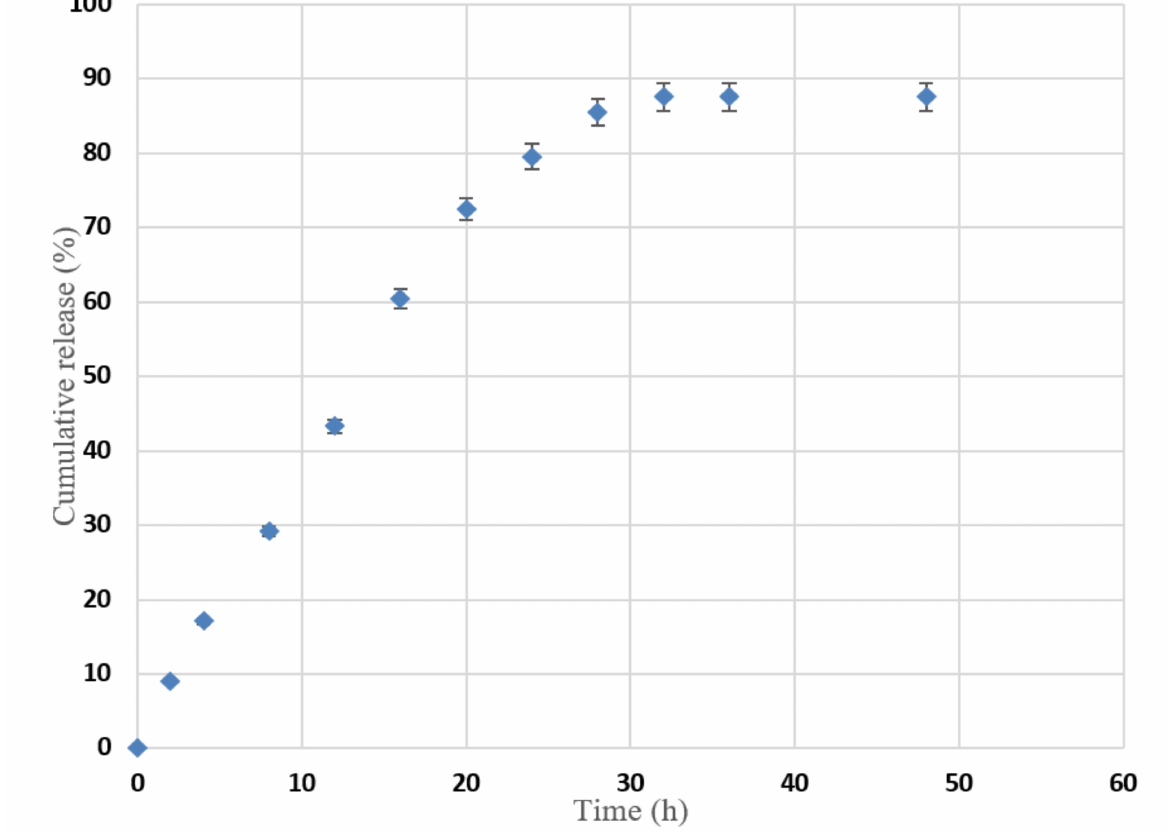
Figure 7. The cumulative nerolidol release as a function of time (expressed as error of standard deviation). In a mouse model, the maximum concentration of free nerolidol achieved was found to be 0.35 µ g/mL 6 h following a single oral dose of 1000 mg/kg [30], and this was